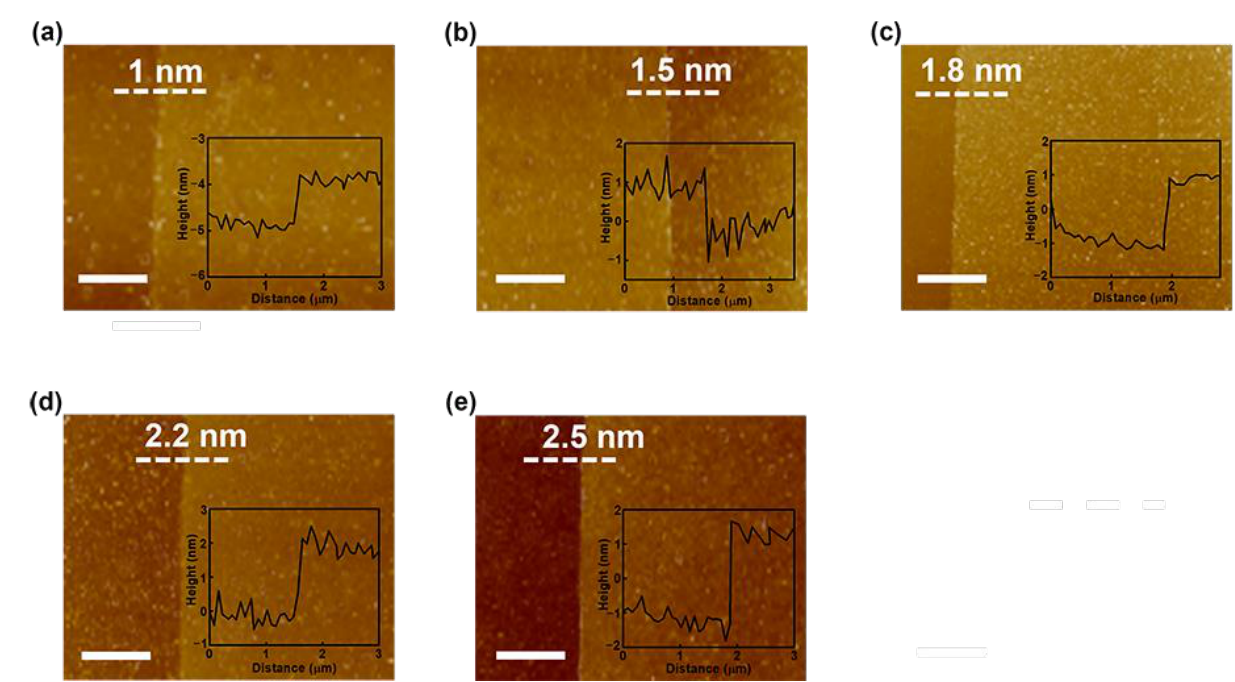
Figure 1. ( a – e ) AFM images of the TiO 2 interlayers with different thicknesses on the SiO 2 substrate. The thicknesses of Ti are 0.2, 0.4, 0.6, 0.8 and 1 nm; these correspond to thicknesses of TiO 2 of 1, 1.5, 1.8, 2.2 and 2.5 nm, respectively. The scale bar is 2 µm.